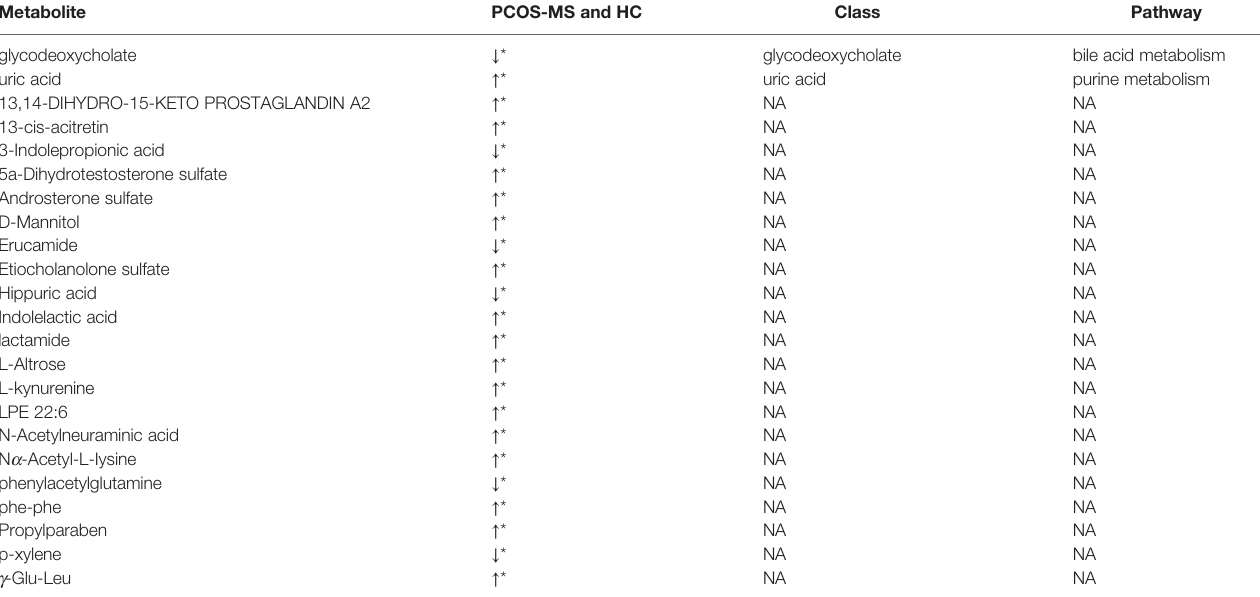
*Represents p < 0.05 when compared PCOS-MS with HC.